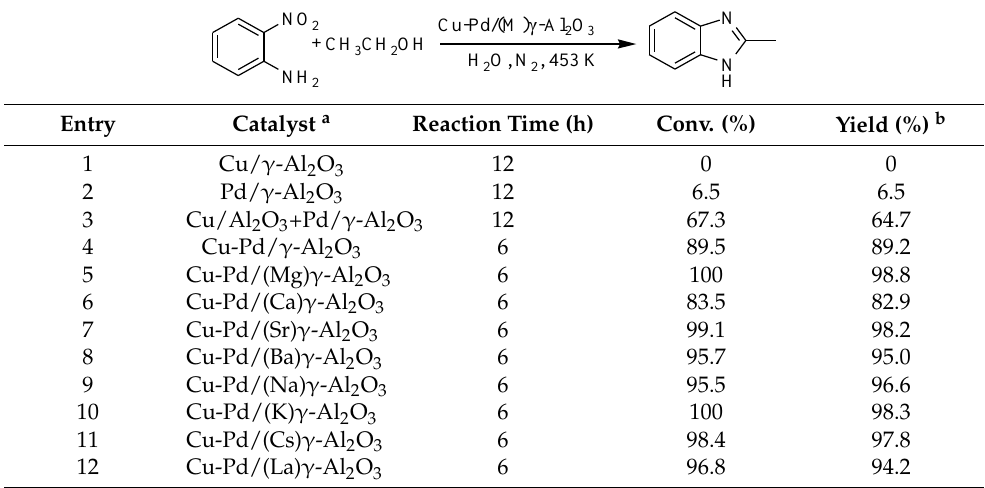
Table 1. Evaluation of the catalytic activity of various catalysts.